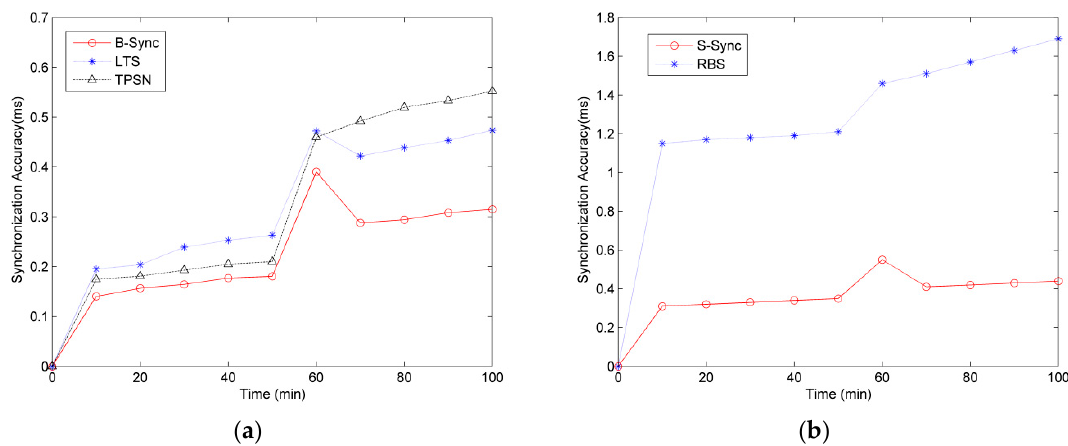
Figure 12. Comparative analysis of robustness. ( a )Base-station to base-station synchronization; and ( b ) base-station to sensor synchronization.